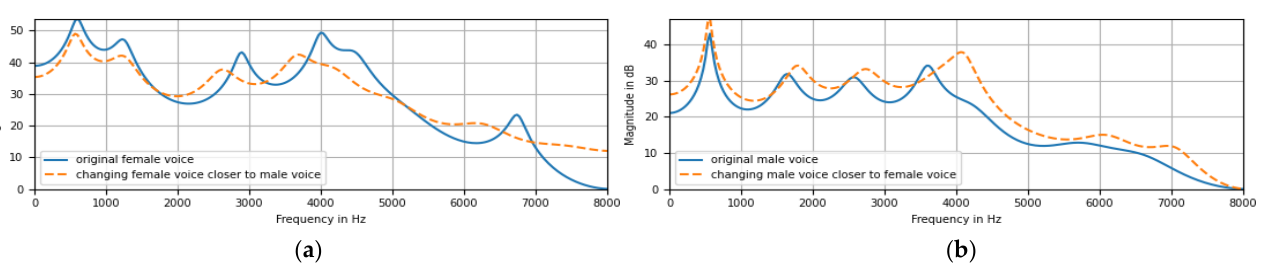
Figure 3. Illustration of the formant translation in two cases: ( a ) consequence of changing female voice closer to a male voice and ( b ) consequence of changing male voice closer to female voice.